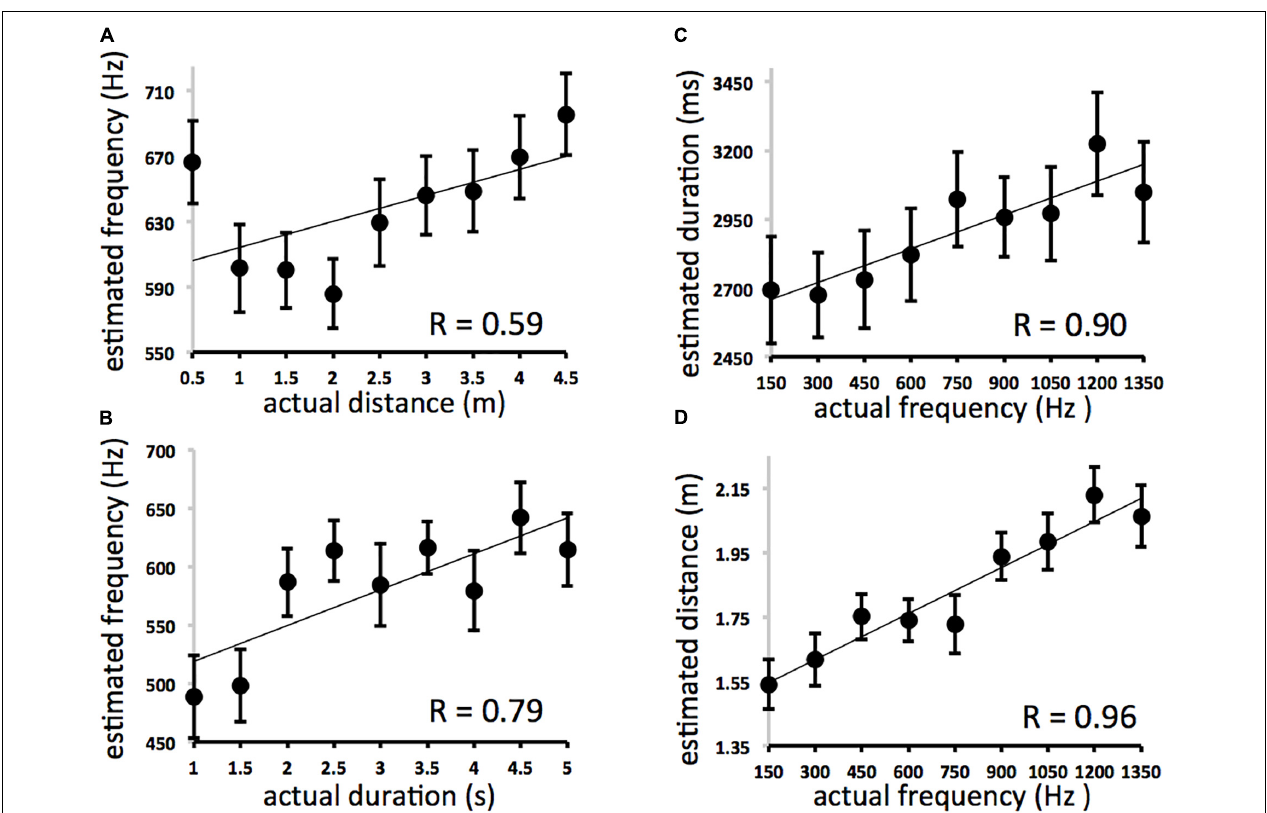
FIGURE 3 | Results for Experiments 2A and 2B. Because all nine intervals used for each domain were fully crossed in Experiment 2, the expected average for estimates across all participants for a particular trial type (distance, duration, or frequency estimation; y -axis) can be described as the average of all nine interval values for that domain presented at each interval of the irrelevant distractor domain (actual frequency, distance, or duration; x -axis). If the irrelevant domain on x exerted no influence on estimation for y one would expect a horizontal line. Deviation from that horizontal represents cross-domain interference. (A) Effect of distance on frequency estimates (expected = 750 Hz at each interval of actual distance). (B) Effect of duration on frequency estimates (expected = 750 Hz at each interval of actual duration). Error bars refer to standard error of the mean. (C) Effect of frequency on duration estimates (expected = 3000 ms at each interval of actual frequency). (D) Effect of frequency on distance estimates (expected = 2.5 m at each interval of actual